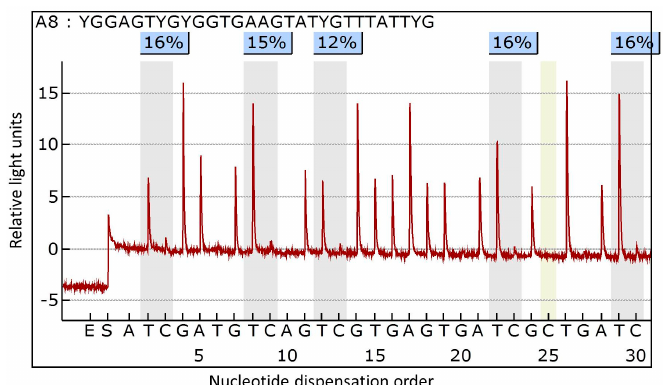
Figure 2. Representative pyrogram of analyzing methylation status of the ALCAM gene using pyrosequencing. The sequence in the upper part of the pyrogram represents the sequence to be analyzed. The gray regions indicate the analyzed C/T sites, with percentage values for the respective cytosine above them. The yellow region indicates the parts where a cytosine was added to verify the complete conversion from unmethylated cytosine to thymine.